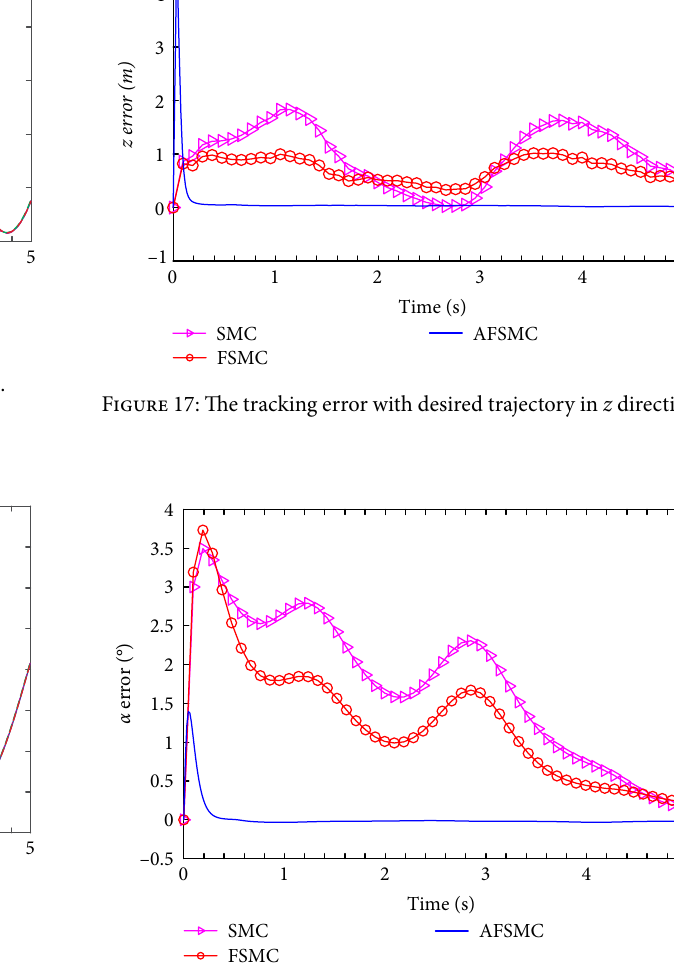
. 3 Figure 18: The tracking error with desired trajectory with rotation . angle 𝛼